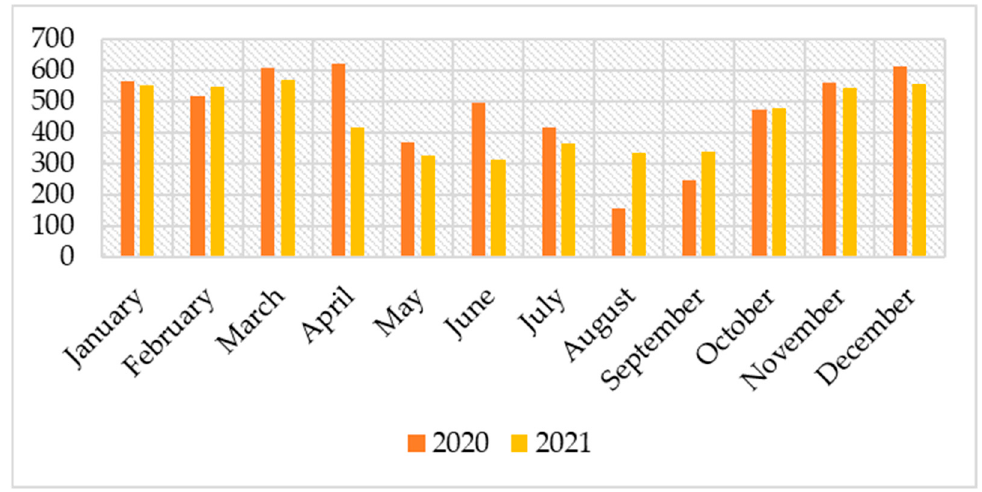
Figure 3. Electricity consumption in 2020 and 2021.